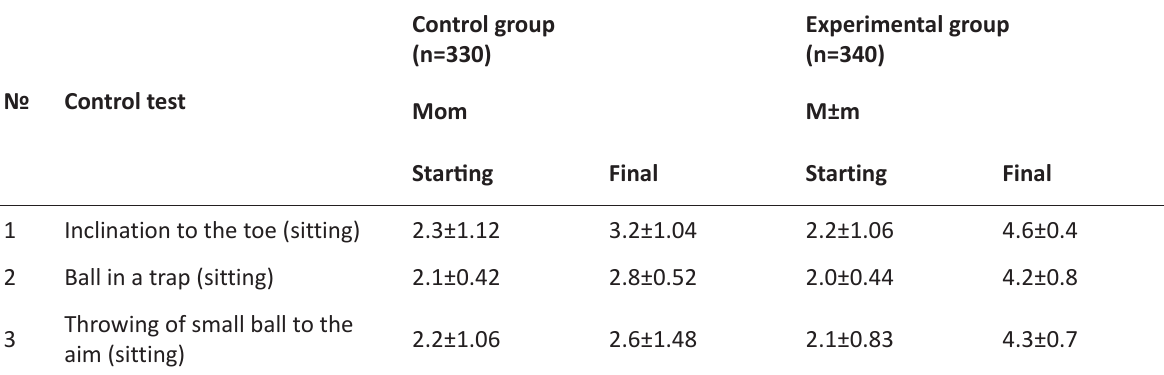
Table 1. Dynamics of physical development of spinal flexibility and coordination of movements of children and teenagers in the experimental and control